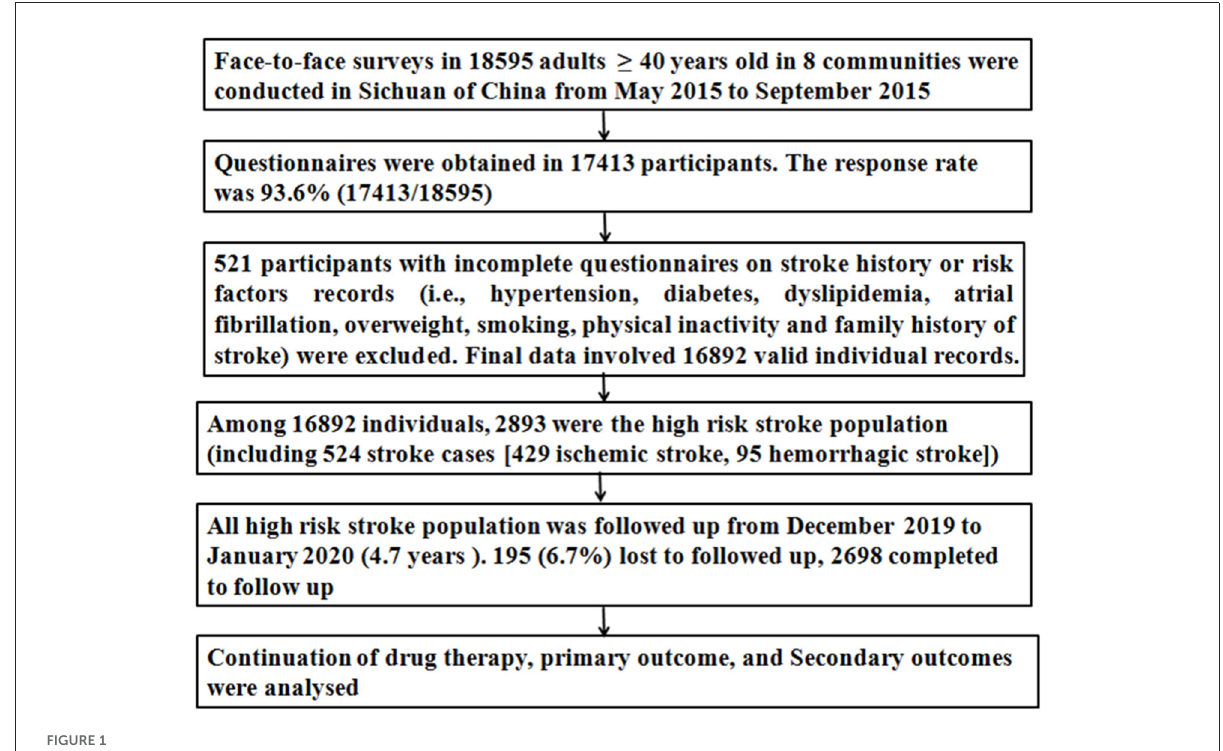
FIGURE1 Flowchart in this